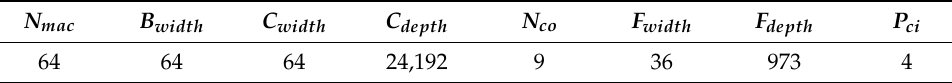
Table 2. Parameters for the proposed implementations.